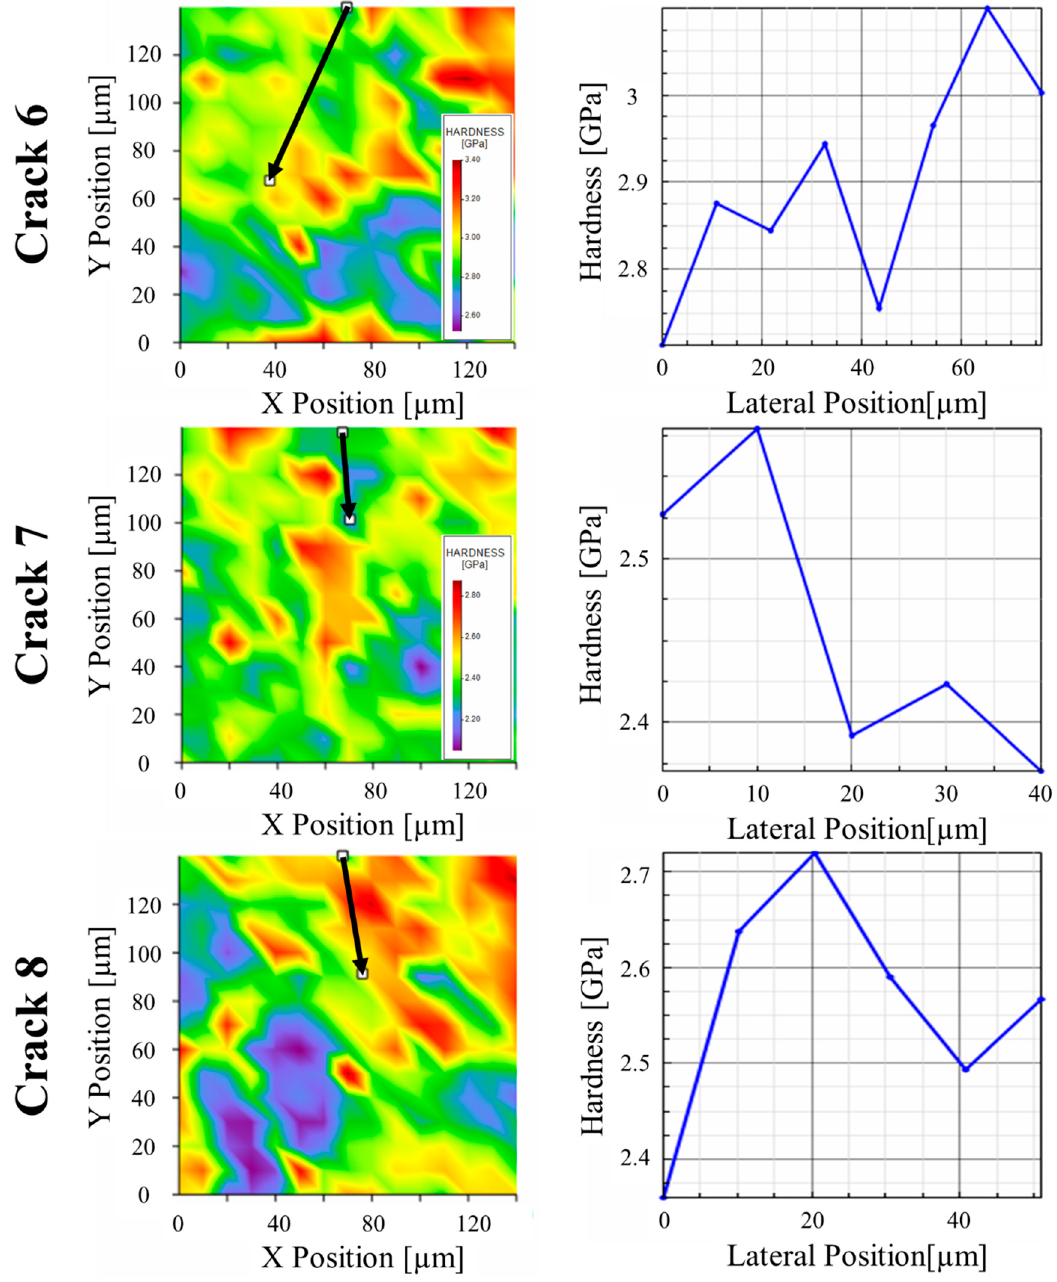
Figure 8. NanoBlitz maps with corresponding intergranular line scan hardness profiles along the arrowed paths of cracks #6–#8. arrowed paths of cracks